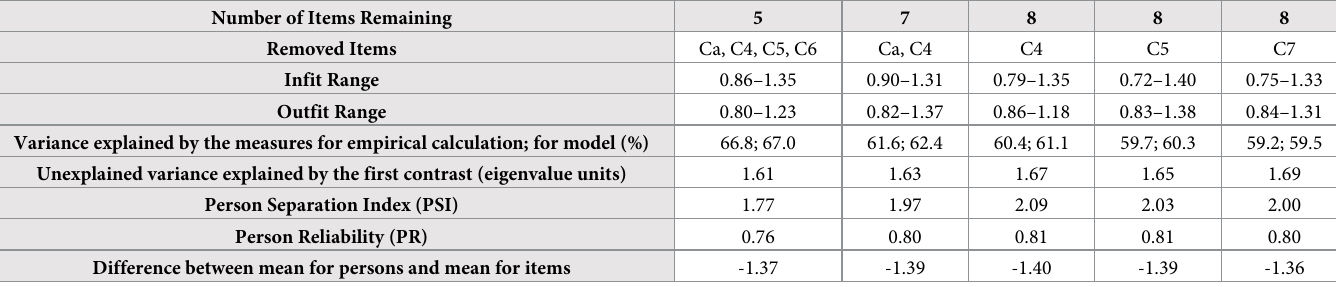
Table 3. Psychometric properties of combinations of Catquest-9SF with best Rasch results.